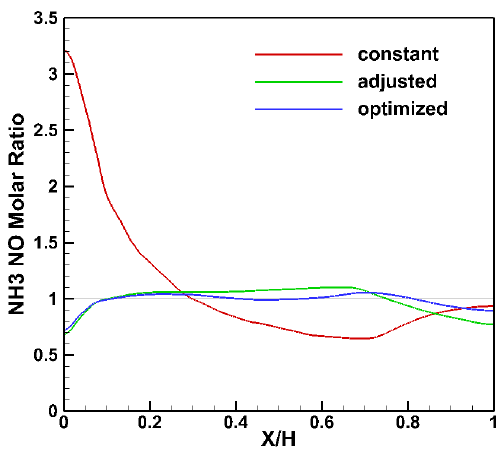
Figure 14. Comparison of NH 3 /NO ratio at the inlet of the catalyst layer for the upper-skewed profile.